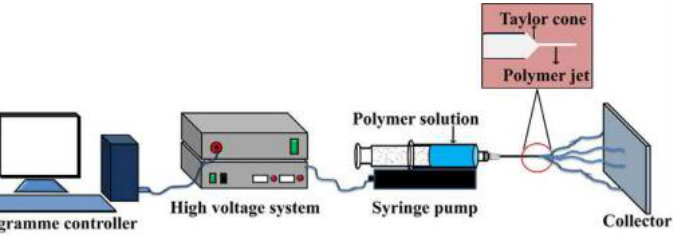
Figure 5. The simplest method of assembling an electrospinning machine [169]. Creative Commons BY-NC-SA.